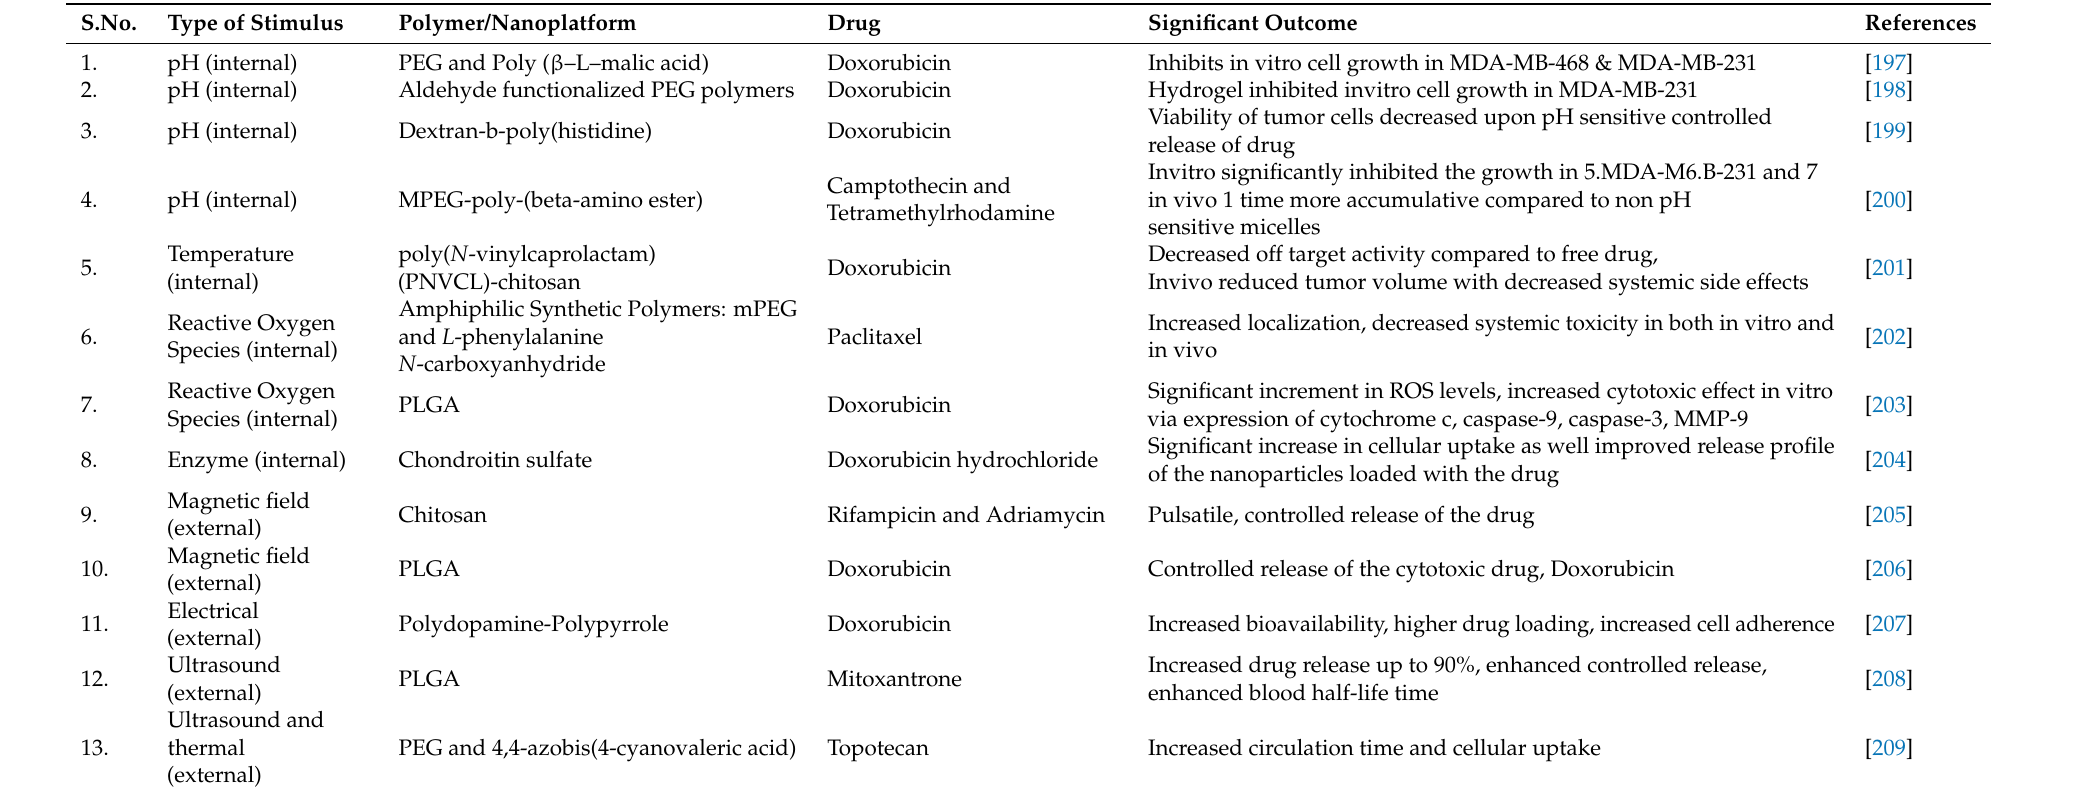
Table 1. Stimuli-based targeting approaches in nano drug delivery system for